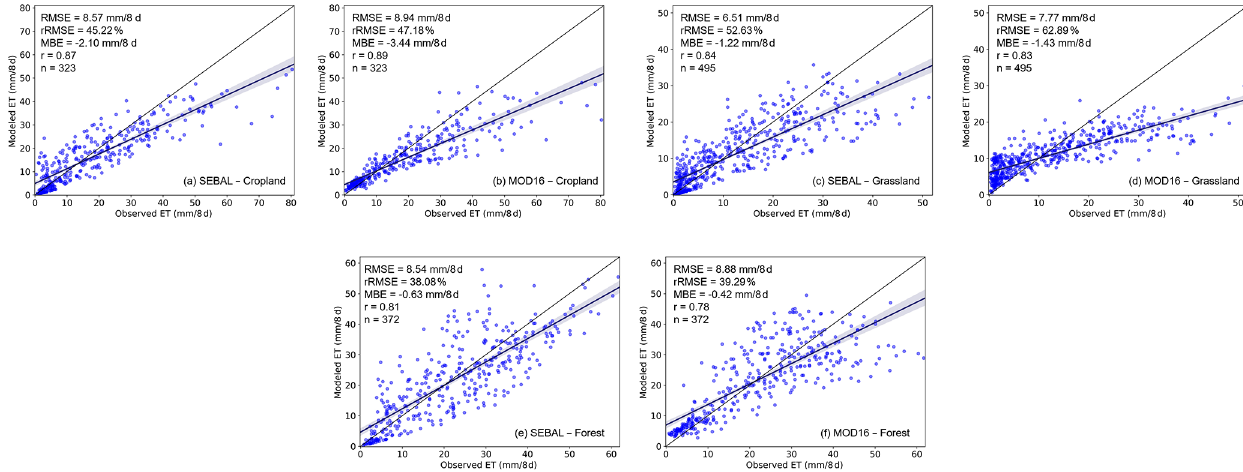
Figure 5. Validations for different land cover types. (a) SEBAL ET for cropland; (b) MOD16 ET for cropland; (c) SEBAL ET for grassland;